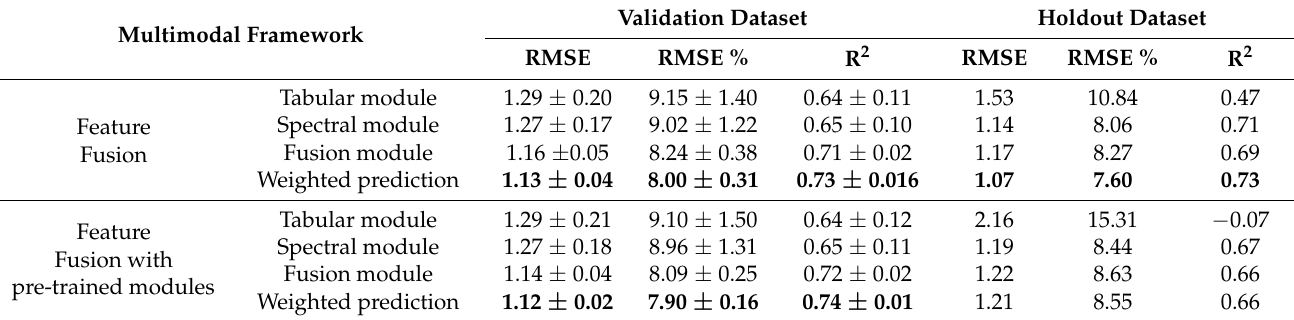
Table 4. Performance comparison of multimodal models with late feature fusion. Validation dataset results were obtained with fivefold cross-validation and presented with standard deviation. The weighted prediction was obtained by scaling each module’s prediction and summing the predicted yield. The best-performing models are highlighted in